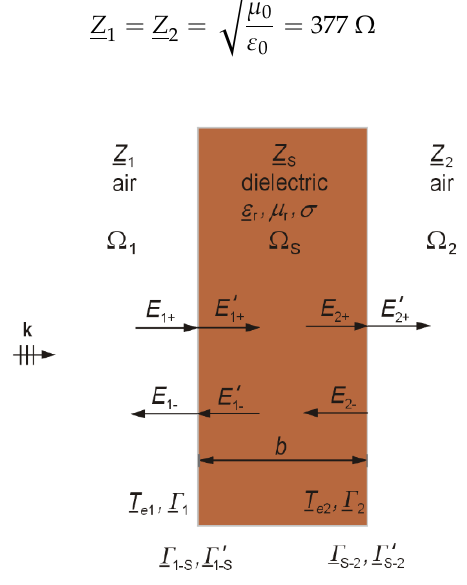
Figure 4. Configuration with a perpendicular plane wave incident on a dielectric slab (wall).